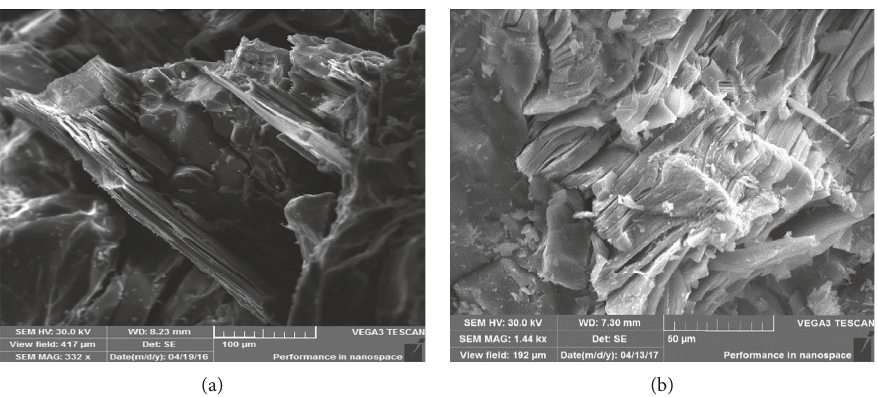
Figure 16: SEM images of phlogopite: (a) without treatment and (b) after freeze-thaw cycling with a minimum temperature of − 50 °